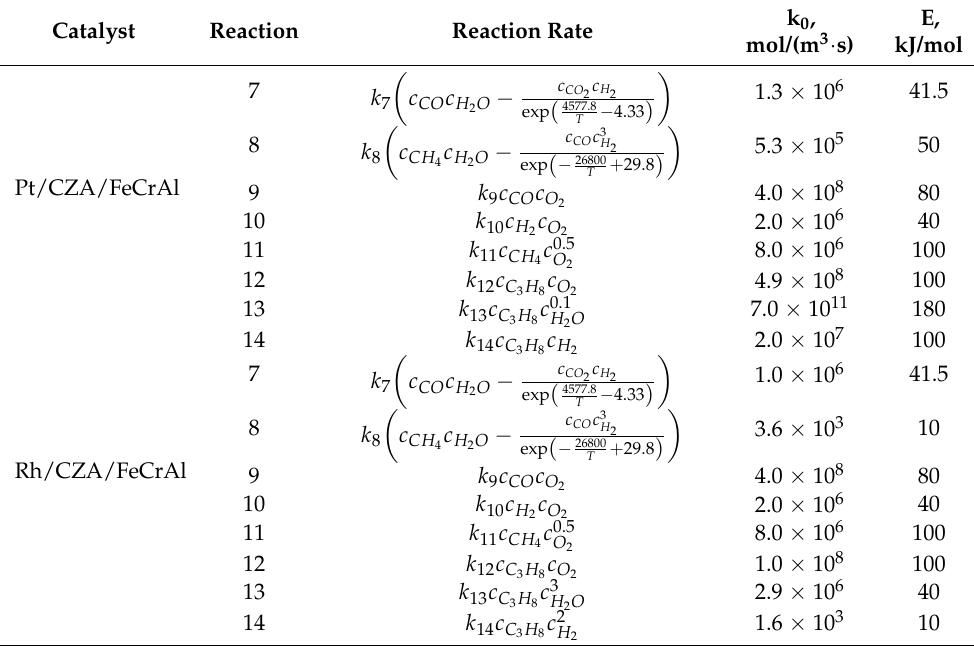
Table 1. Kinetic parameters for Equations (7)–(14). Catalyst Reaction